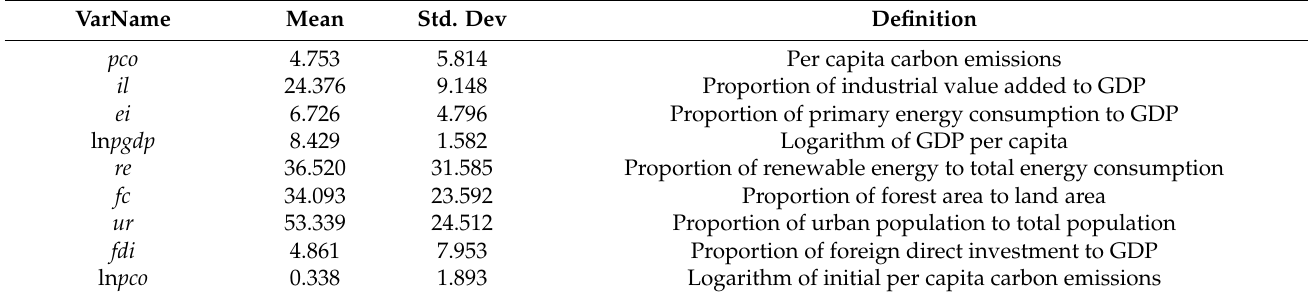
Table 1. Descriptive statistics of